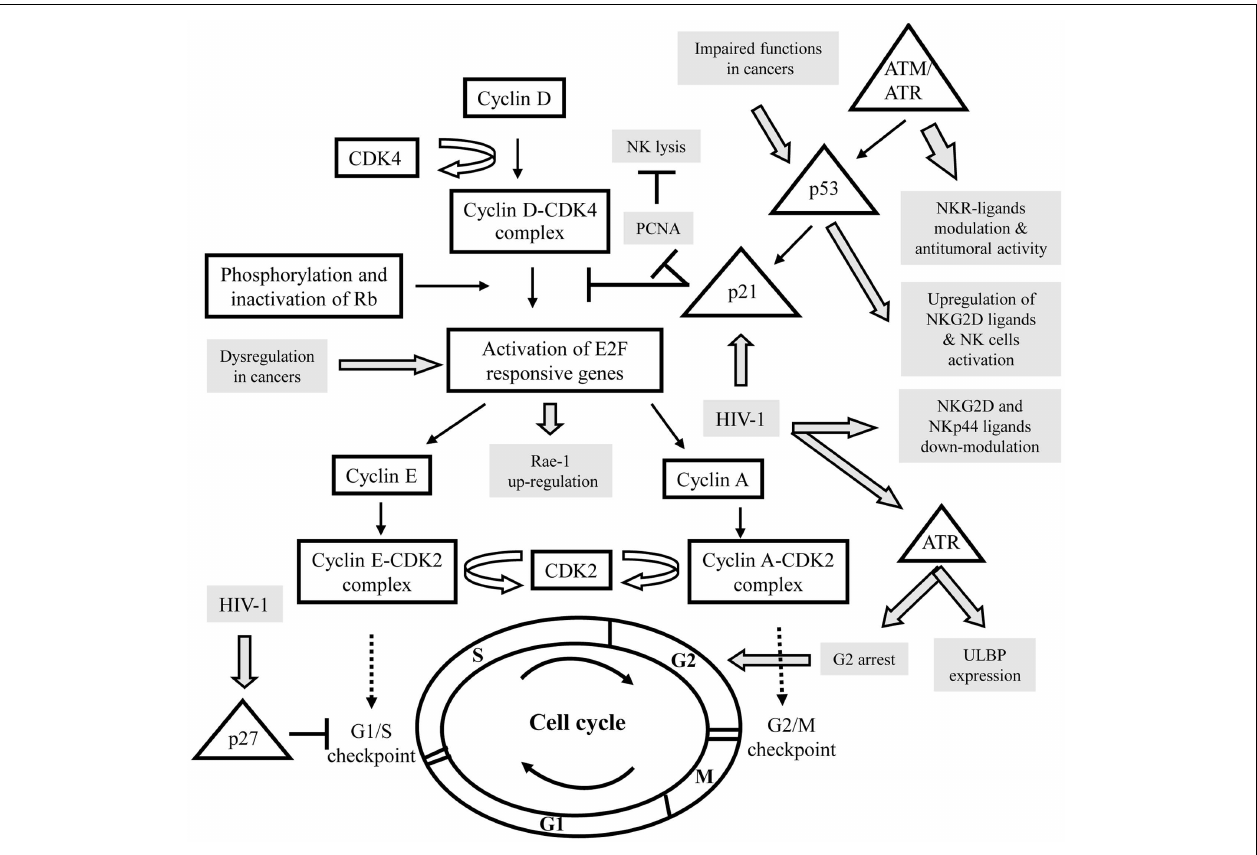
NK ligands expression in cancers or viral infections is indicated in gray. CDK, cyclin-dependent kinase; Rb, retinoblastoma tumor suppressor gene; ATM, ataxia-telangiectasia-mutated; ATR, ataxia, and rad3 related; PCNA, proliferating cell nuclear